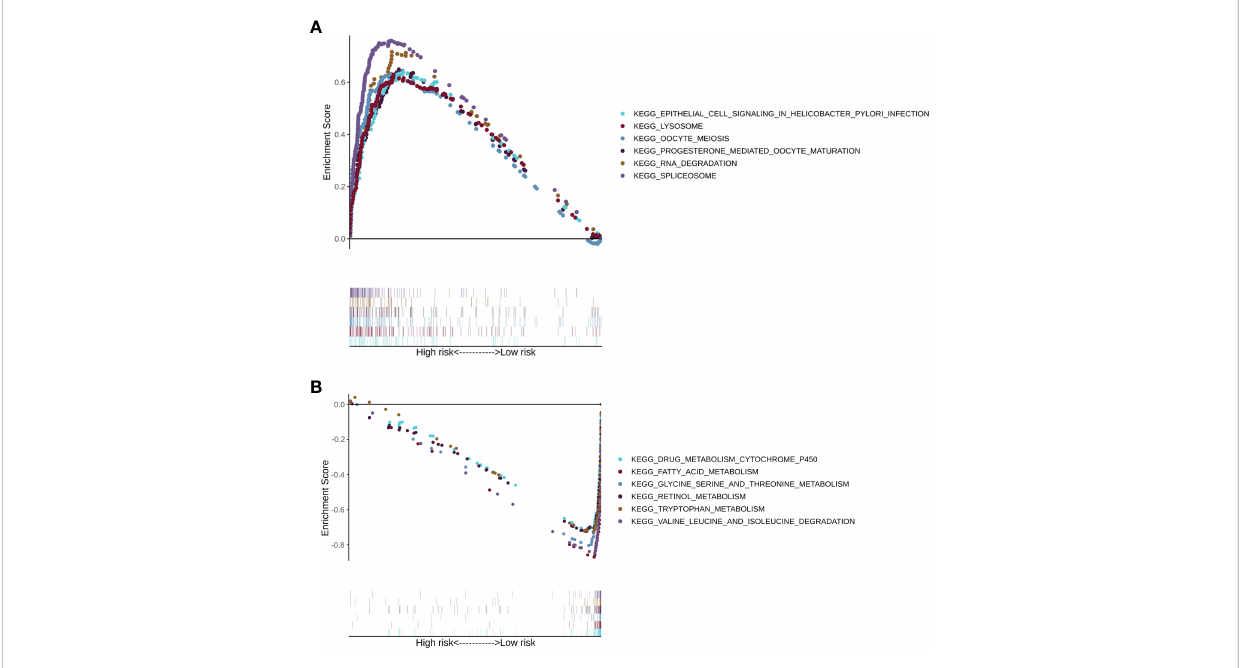
FIGURE 7 The KEGG pathway enrichment analysis of patients in the LMRG high- and low-risk groups. (A) Enriched pathways in the LMRG high-risk group. (B) Enriched pathways in the LMRG low-risk group.